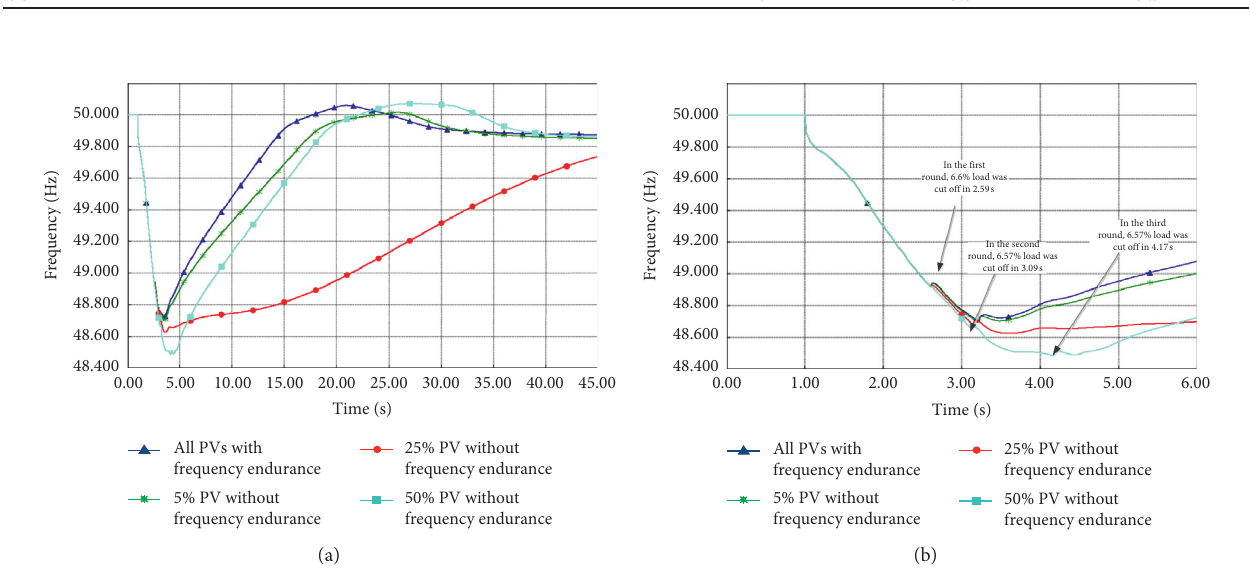
Figure 6: Frequency response of power system when the distributed photovoltaic generation without frequency endurance capability in different proportions: (a) The dynamic diagram of the whole process and (b) the partial enlarged drawing.